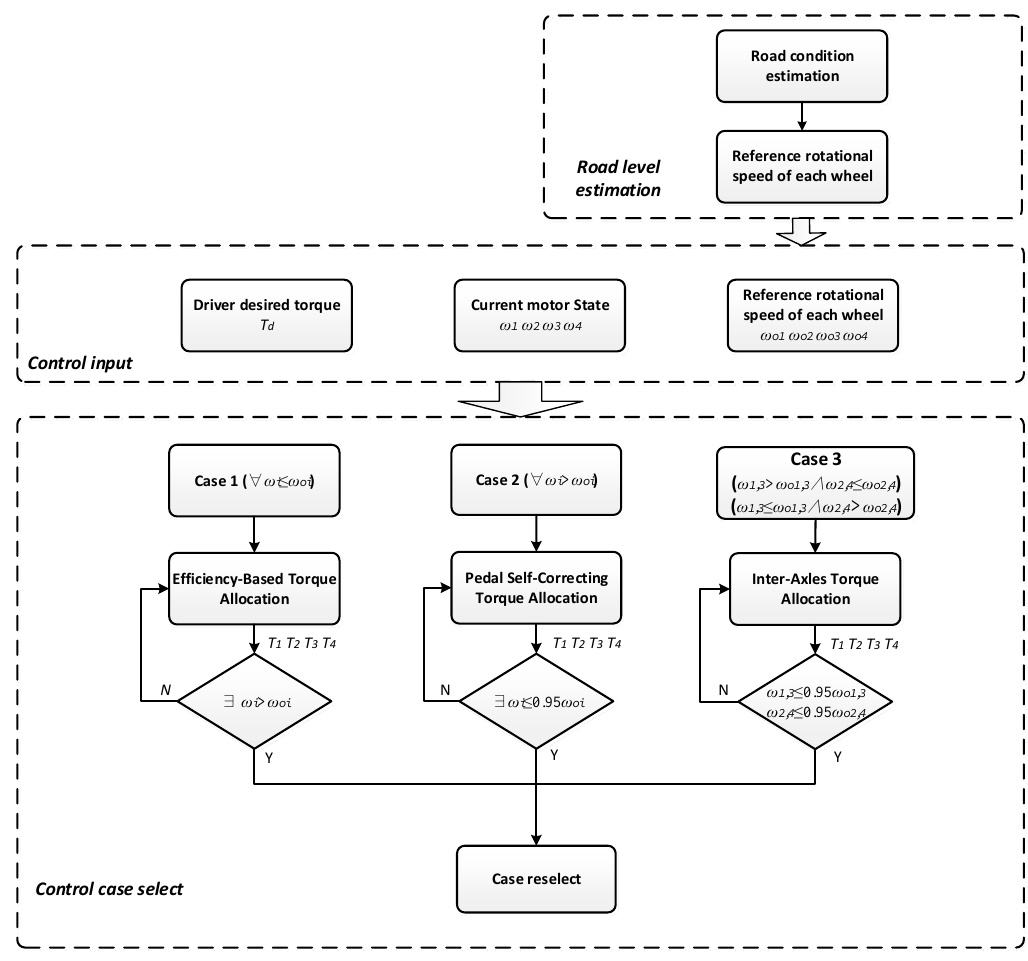
Figure 5. Structure of the integrated control strategy ( ∀ : for all; ˄ : or; ∃ : there exist).